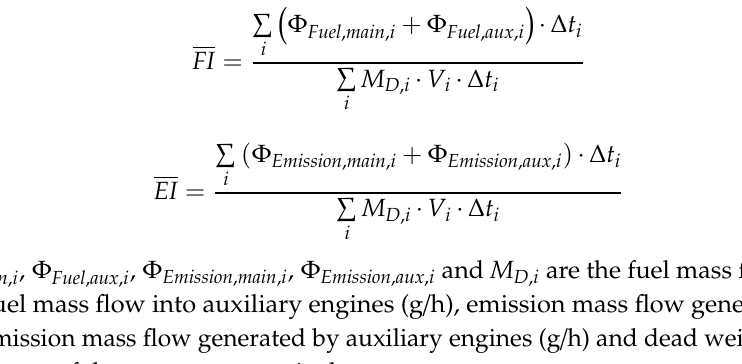
Table 2. Particulars of the main engine and auxiliary engines.